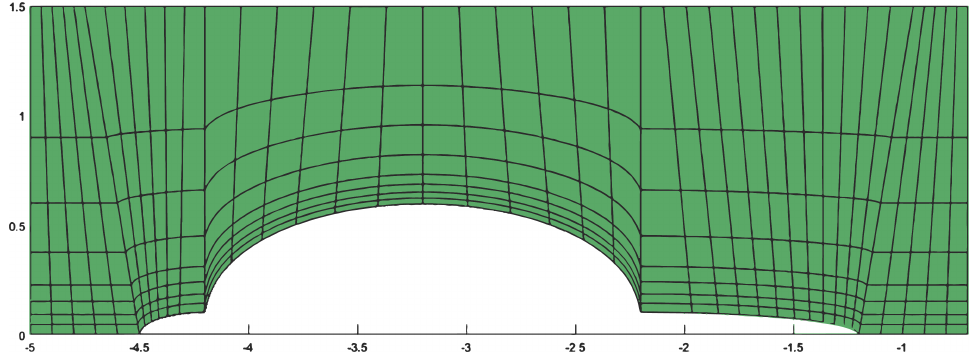
Figure 28. Case 6: physical domain and mesh.